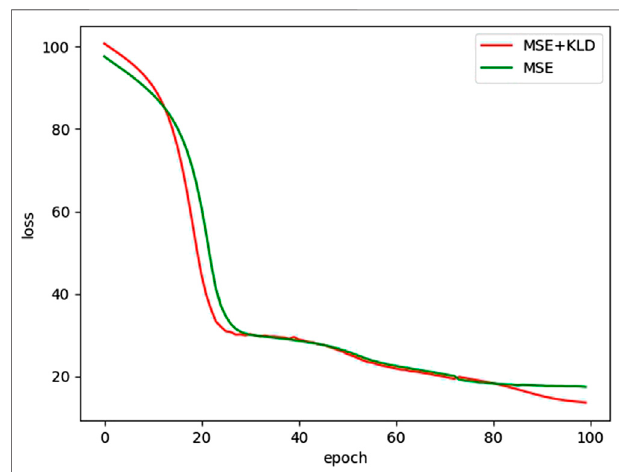
FIGURE 4 | The loss of the KDAE and